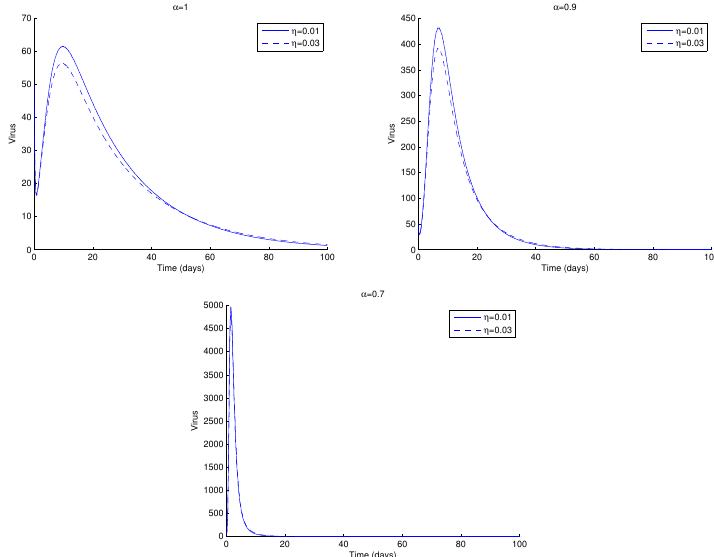
Figure 10. HIV, viral load, V , of system (1) for different therapy strategies and for α = 1 ( top left ), α = 0.9 ( top right ) and α = 0.7 ( bottom ). Parameter values and initial conditions in the text, except R k = 1 and η = 0.01. For more information, see text.